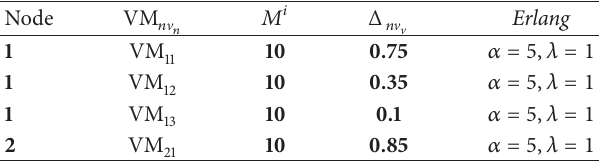
Table 4: Without communications. Low optimal Erlang . Preserving